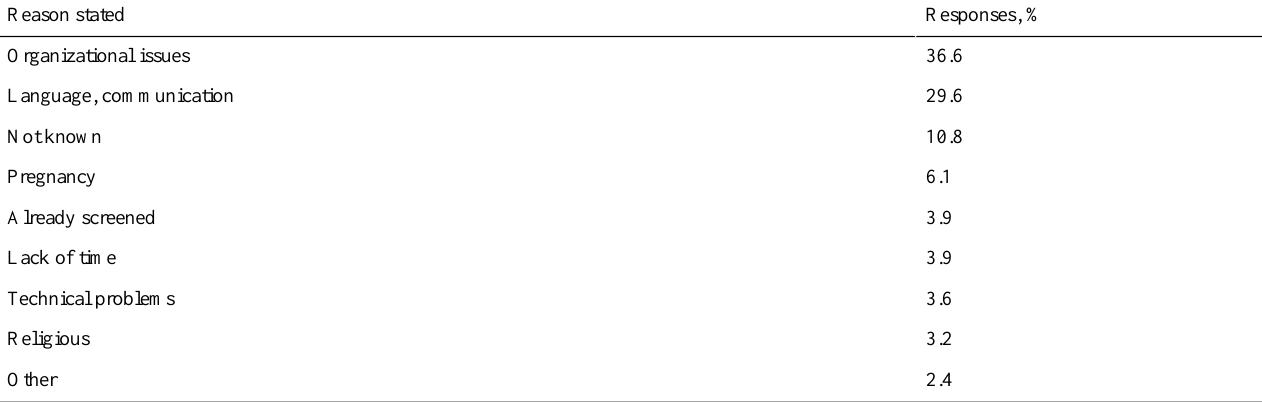
Table 1. Reasons health professionals are not offering screening.